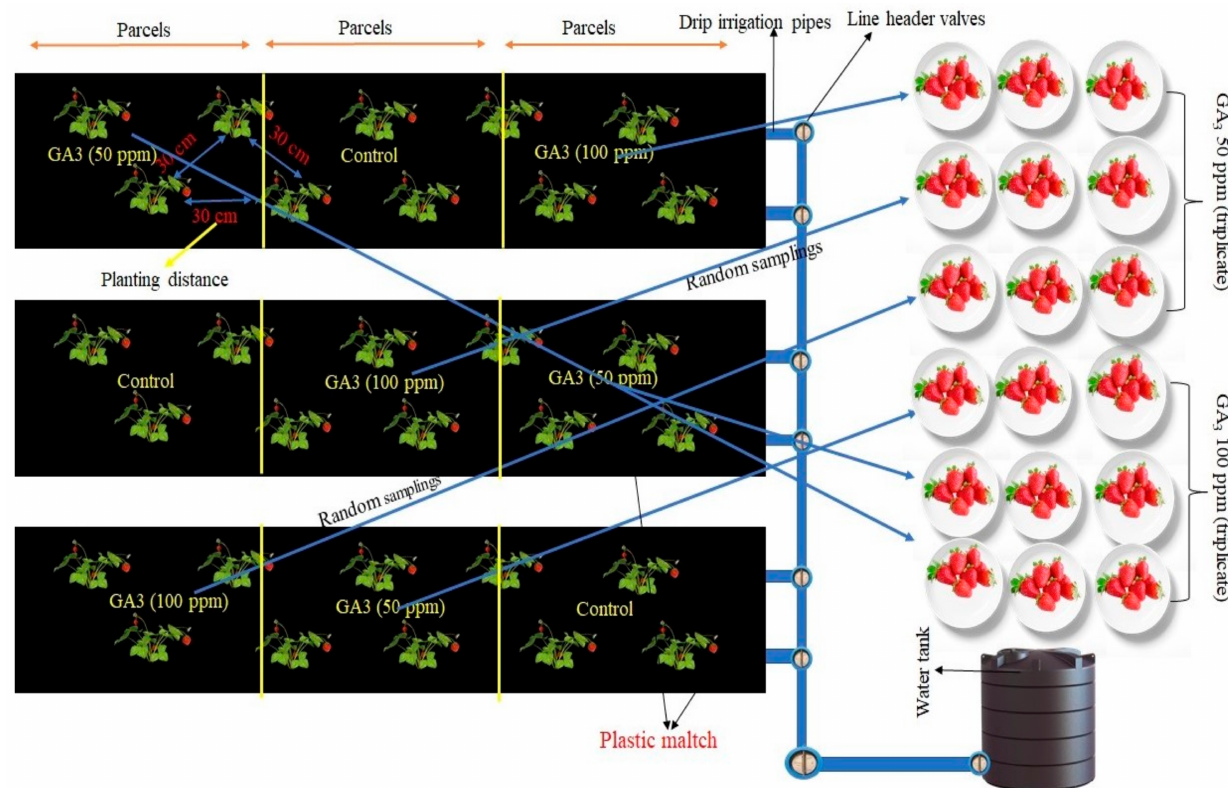
Figure 3. A summarized scheme of the field trial. The same procedure was implemented for the control